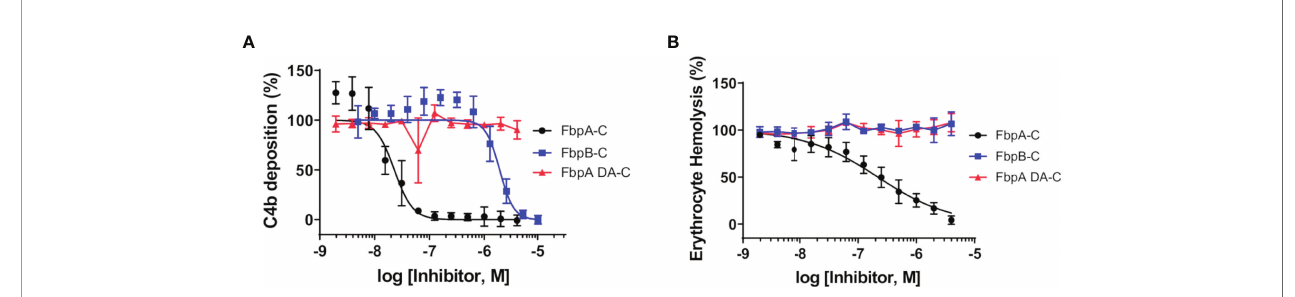
FIGURE 4 | Assessing the complement inhibitory properties of B. miyamotoi FbpA and FbpB in vitro . (A) An ELISA-based assay speci fi c for CP complement activation was used to determine if FbpA-C and FbpB-C were able to inhibit human CP progression. FbpA-C, FbpA DA-C, and FbpB-C, were serially diluted two- fold then incubated with normal human serum, followed by detection of deposited C4b. IC 50 values were determined using normalized non-linear regression analysis and reported in Table 4 along with 95% con fi dence intervals. (B) A CP hemolysis assay was carried out using a two-fold serial dilution of Fbp proteins incubated with pre-sensitized sheep erythrocytes and 2% normal human serum. MAC formation and progression of the CP was measured by detecting MAC-mediated erythrocyte hemolysis. IC 50 values were determined using normalized non-linear regression analysis and reported in Table 4 along with 95% con fi